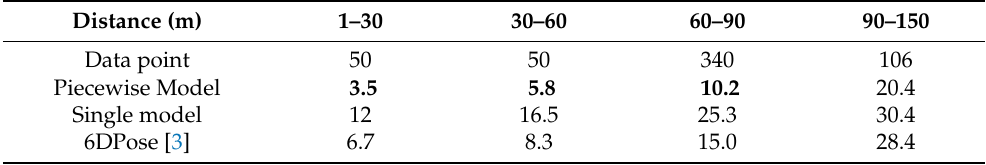
Table 1. Average location error predicted by the algorithm, grouped by target distance.